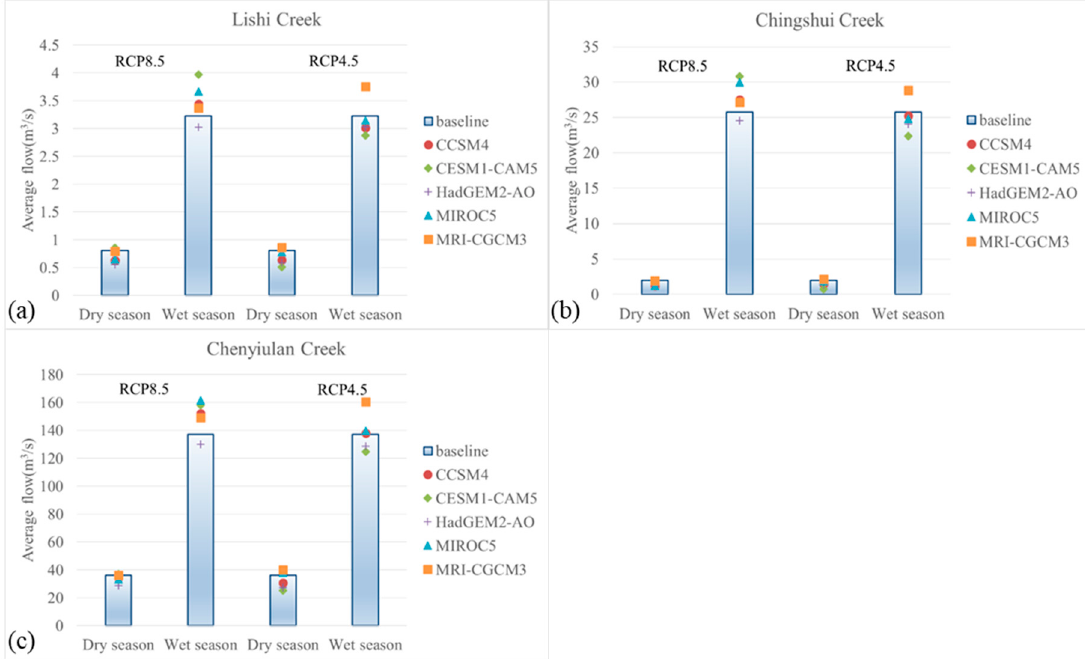
Figure 7. Changes of flows of Lishi Creek ( a ), Chingshui Creek ( b ), and Chenyiulan Creek ( c ) in the wet and dry seasons under baseline and future scenarios.